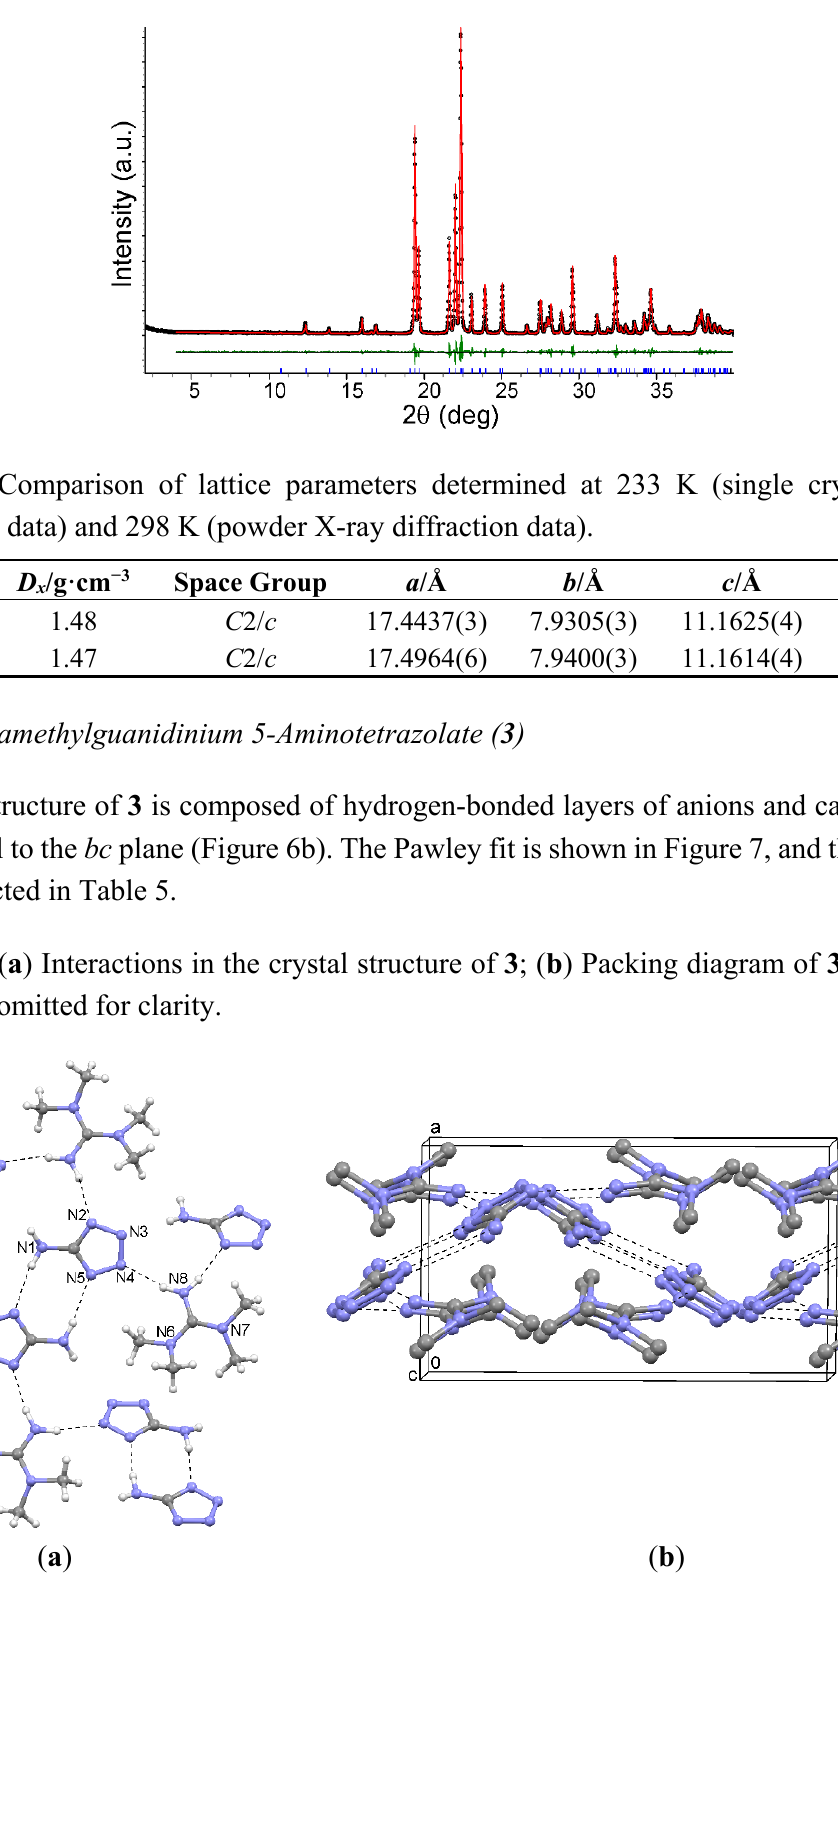
Figure 5. Pawley fit ( R wp = 9.04%, R exp = 7.96%, R p = 6.89%, gof = 1.14) of the PXRD data of 2 with a model calculated from the structural data of the single crystal structure determination.